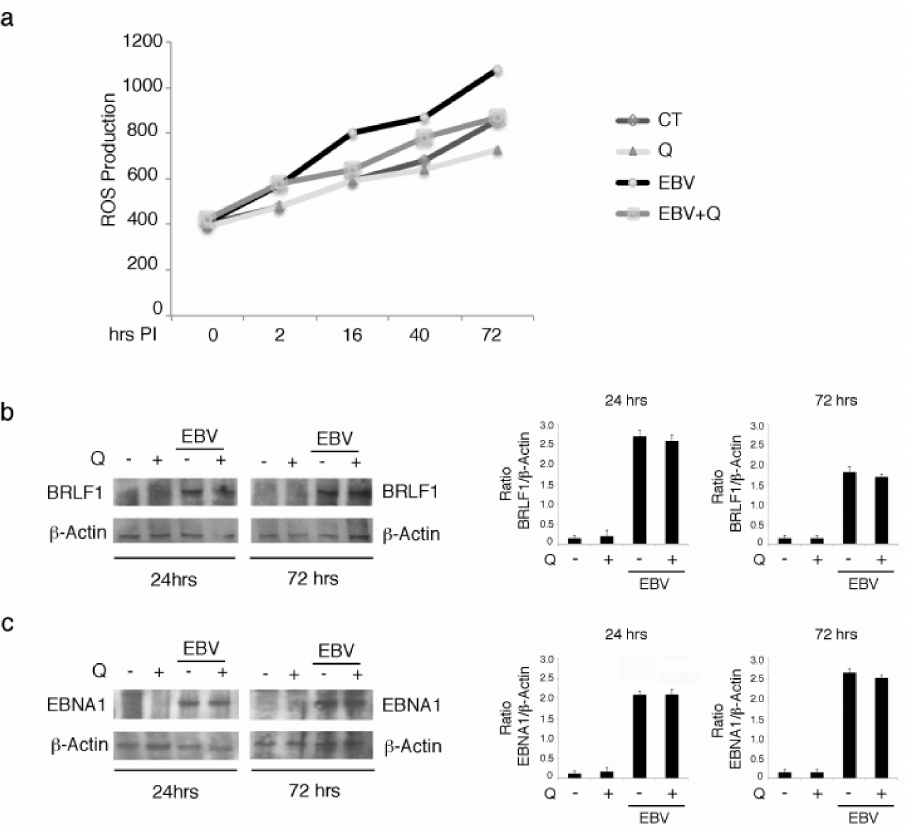
Figure 4. Quercetin reduces reactive oxidative species (ROS) but does not a ff ect BRLF1 expression in EBV-infected B lymphocytes. ( a ) Time-dependent increase of intracellular ROS evaluated by 2 (cid:48) ,7 (cid:48) -dichlorofluorescein diacetate (DC-FDA) staining and FACS analysis. The mean of fluorescence intensity is reported on the Y-axis ( b ). ( c ) BRLF1 and EBNA1 expression levels as evaluated by western blot analysis following EBV infection of B cells, with or without treatment with quercetin. Densitometric analysis was performed using Image J software, and the ratio of BRLF1 vs. b-actin was calculated. Histograms represent the mean ± SD of three independent